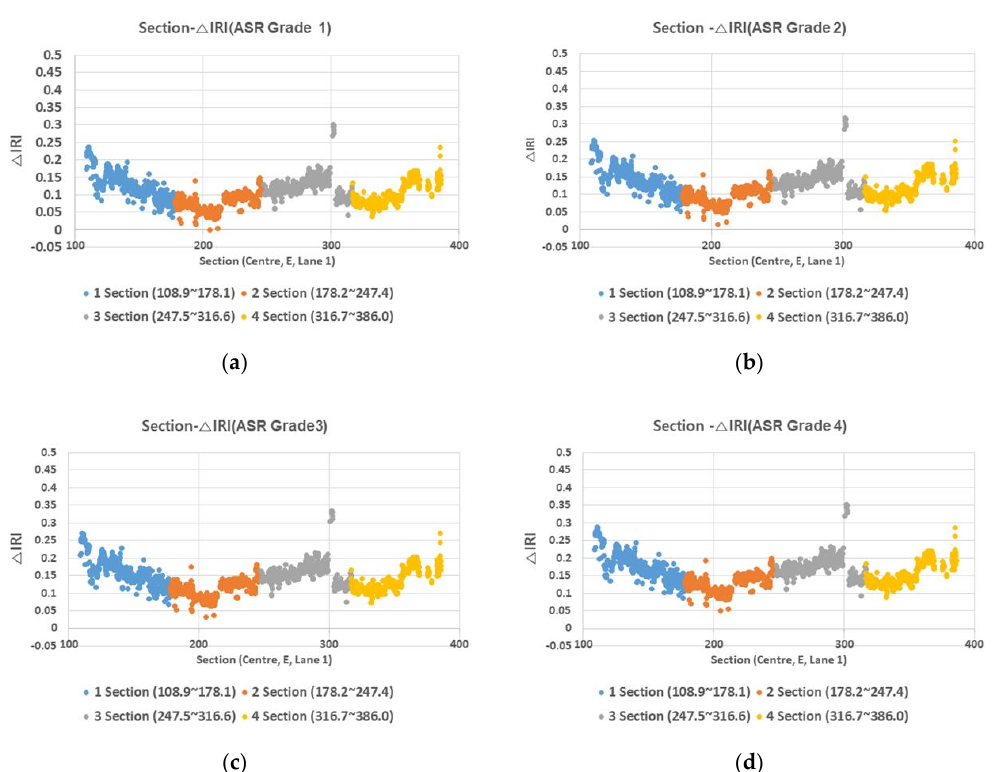
Figure 2. Section-change in international roughness index ( △ IRI) (ASR grade) relationship. ( a ) ASR grade 1; ( b ) ASR grade 2; ( c ) ASR grade 3; and ( d ) ASR grade 4.